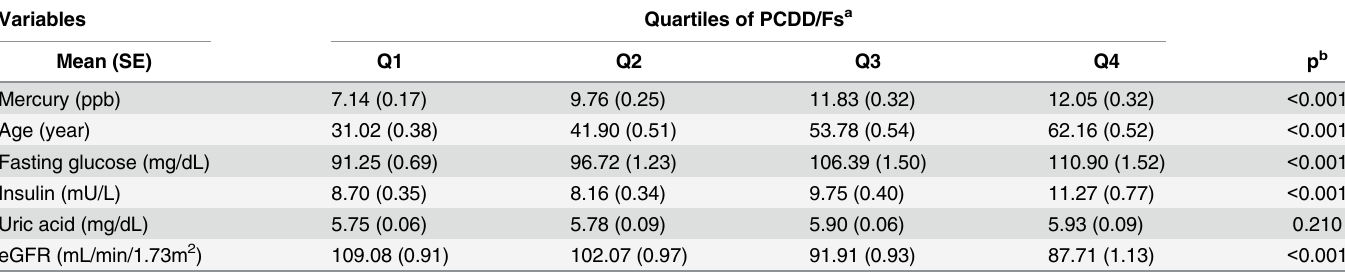
Table 2. Means and standard errors (SEs) of variables according to quartiles of PCDD/Fs.